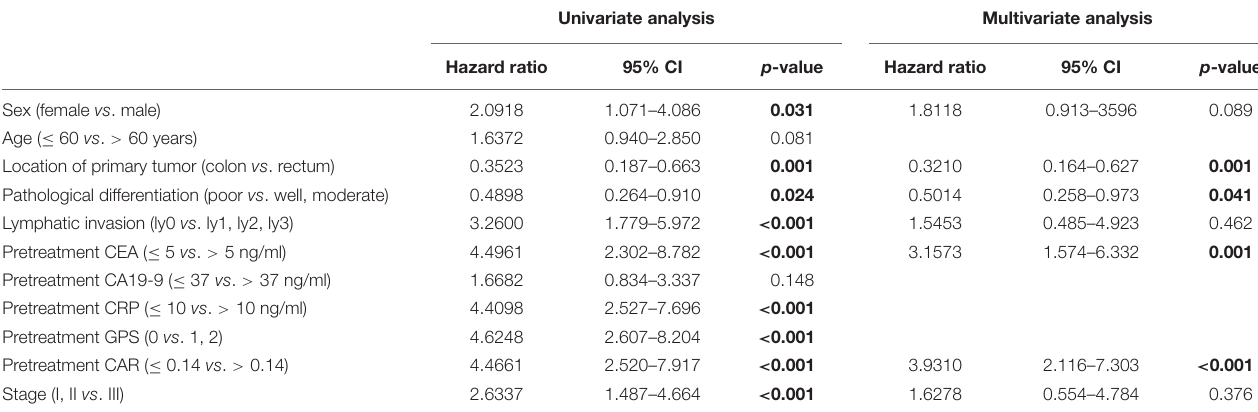
TABLE 4 | Correlations between overall survival and the clinicopathological factors in stage I–III CRC patients.